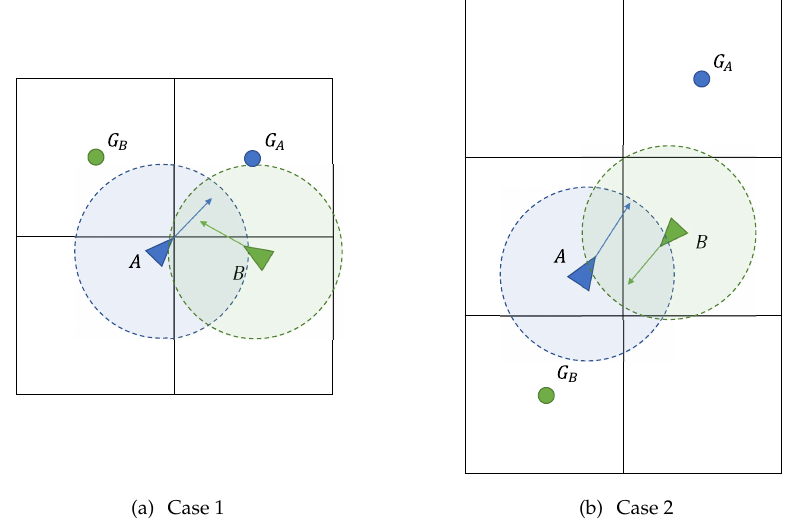
Figure 3. Examples of situations in which a collision may take place. Agents A (blue) and B (green) head to their respective goal cell, G A and G B . A safety region with a radius R safety has been drawn surrounding each agent with the color of the agent that belongs